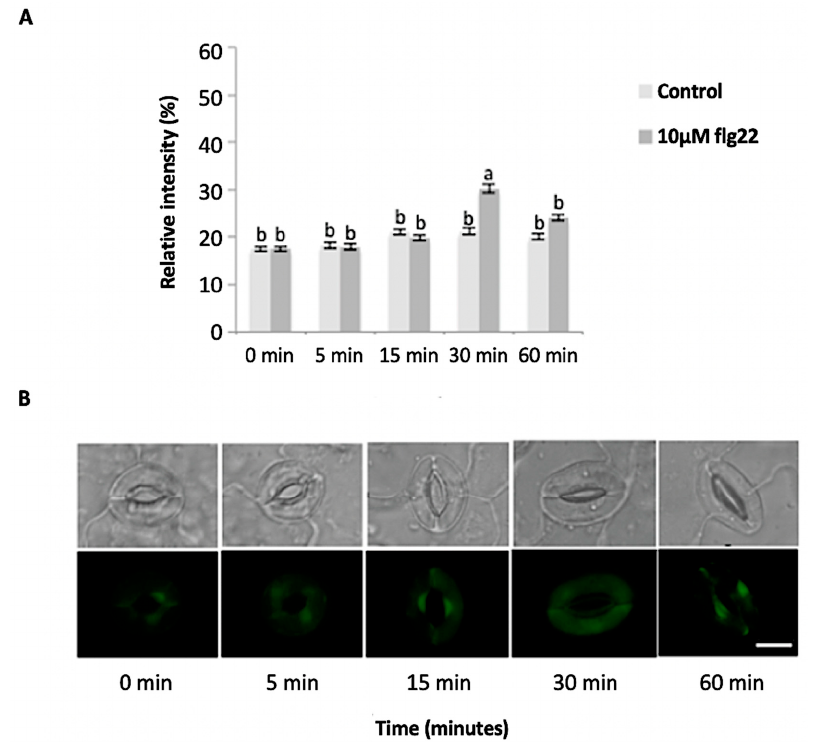
Figure 4. Guard cell nitric oxide (NO) levels in response to 10 µM flg22. ( A ) NO levels measured from a total of 180 stomata from three independent experiments and presented as means ± SE. Different letters indicate significantly different mean values at p < 0.05. ( B ) Representative images of stomatal guard cells at each time point are shown. Scale bar: 10 µm.